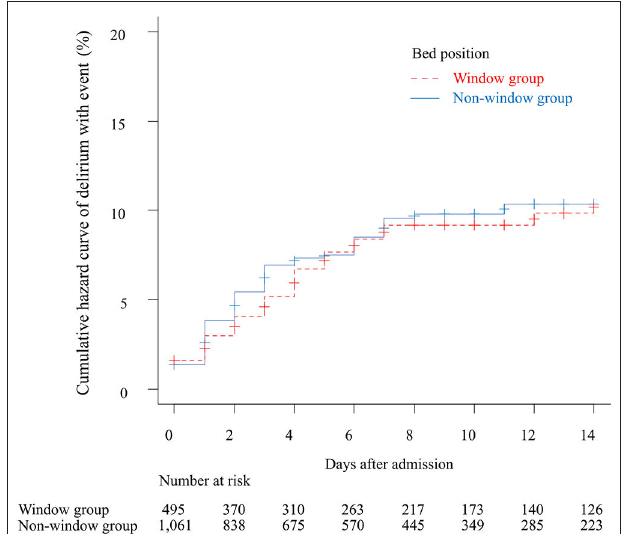
FIGURE 3 | Unadjusted cumulative curves for the primary outcome. The figure shows the cumulative curves of delirium with event within 14 days after admission. The dotted red line indicates the window group and the solid blue line indicates the non-window group.